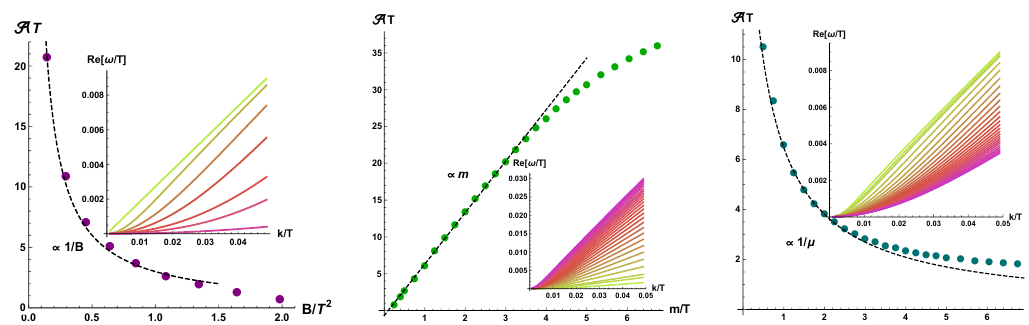
Figure 12 . The coe(cid:14)cient A extracted from the dispersion relation of the type-B magnetophonon Re [ ! ] (cid:24) A k 2 as a function of the parameters of the system. Left: As a function of the dimensionless magnetic (cid:12)eld B=T 2 (cid:12)xing m=T = (cid:22)=T = 1. The inset shows the dispersion relation of the magnetoplasmon increasing the magnetic (cid:12)eld (from green to pink). Center: As a function of the graviton mass m=T (cid:12)xing (cid:22)=T = 1 and B=T 2 = 0 : 5. The inset shows the dispersion relation of the magnetoplasmon increasing m=T (from green to pink). The dashed line shows the low m linear scaling compatible with the hydrodynamic formula. Right: As a function of the dimensionless chemical potential (cid:22)=T (cid:12)xing m=T = 1 and B=T 2 = 0 : 5. The inset shows the dispersion relation of the magnetoplasmon increasing the chemical potential (from green to pink). The dashed line shows the (cid:24) 1 =(cid:22) scaling compatible with the hydrodynamic formula.